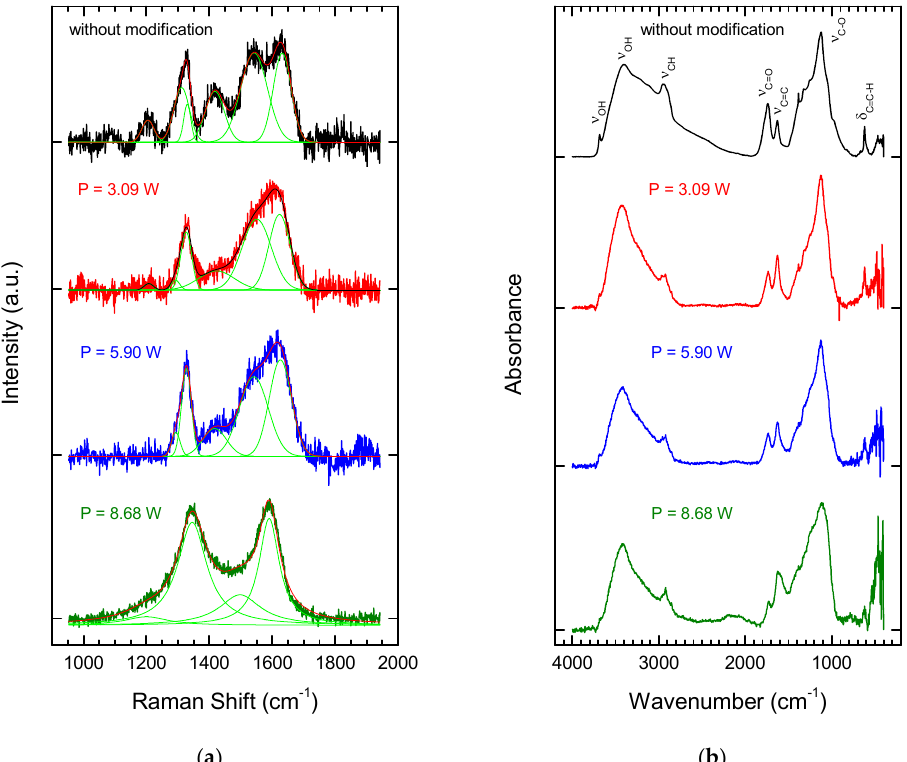
Figure 2. Raman ( a ) and FT-IR spectra ( b ) of nanodiamond particles (NDPs) before and after laser treatment conducted with three average values for laser power.